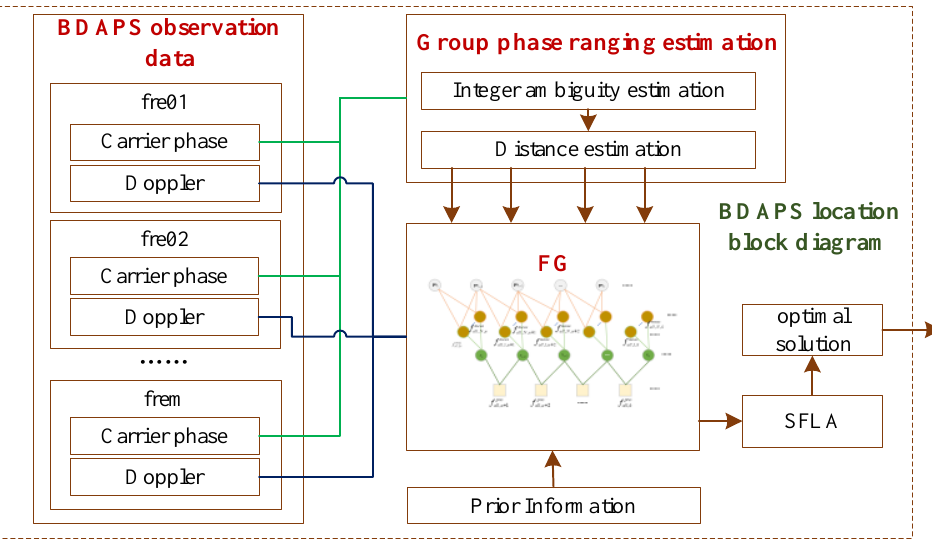
Figure 4. The algorithm processing block